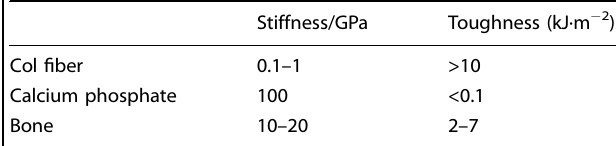
Table 1. Mechanical properties of bone and its main